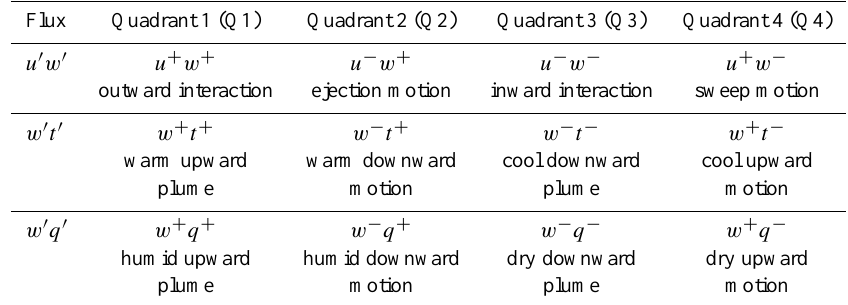
Table 2. Description of quadrant events for momentum ( u 0 w 0 ), heat ( w 0 t 0 ) and water vapor ( w 0 q 0 ) fluxes and their associated event names. For any variable x : x + signifies x 0 > 0, and x − signifies x 0 < 0. Flux Quadrant 1 (Q1) Quadrant 2 (Q2) Quadrant 3 (Q3) Quadrant 4 (Q4) u 0 w 0 u + w + u − w + u − w − u + w − outward interaction ejection motion inward interaction sweep motion w 0 t 0 w + t + w − t + w − t − w + t − warm upward warm downward cool downward cool upward plume motion plume motion w 0 q 0 humid upward humid downward dry downward dry upward plume motion plume